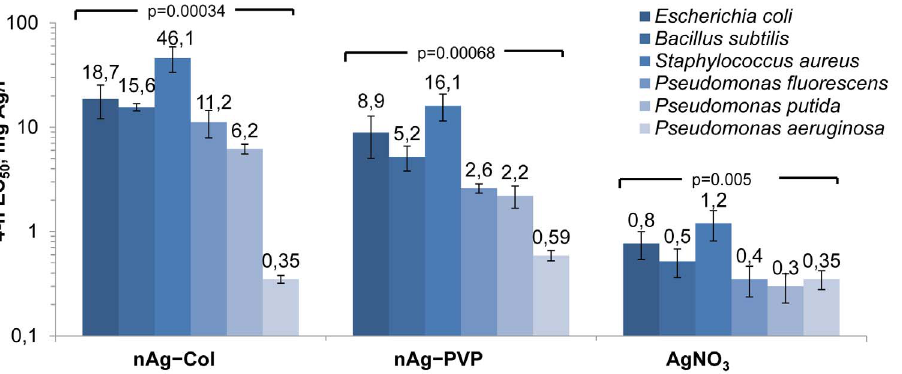
Figure 2. 4-h EC 50 values (endpoint: growth inhibition; note the logarithmic scale) for different silver formulations to bacteria. nAg- PVP states for PVP-coated AgNPs and nAg-Col for collargol. Concentrations are nominal. Data represent the average 6 SD (n=3), p-values denote statistically significant differences between different bacteria (ANOVA).